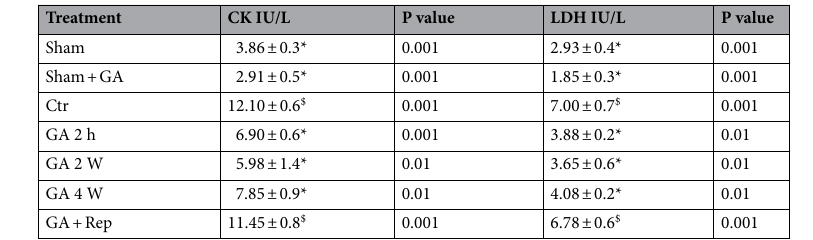
Table 2. Effects of ischemia/reperfusion and GA treatment on cardiac enzymes levels (n = 8). CK creatine kinase; LDH lactate dehydrogenase, Ctr control, GA 2 h gum arabic infusion 2 h before sacrifice, GA 2